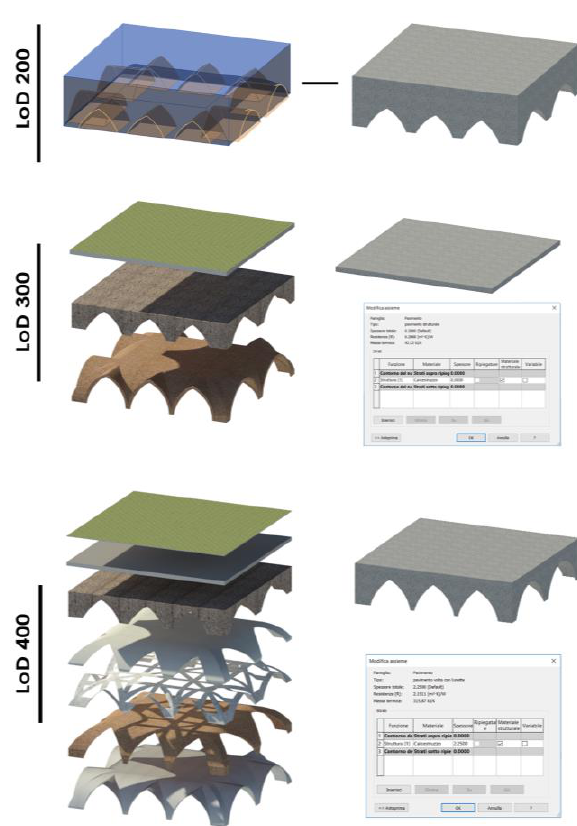
Figure 5. Modelling of a Cavetto vault with lunettes, with different Levels of Development: the LoD 200 vault (on the left the construction of a simplified model in-place of the vault, on the right the final result); the 300 LoD vault (the model in-place with a simplified stratigraphy of the vault and a simplified shape of a structural floor to be superimposed); the LoD 400 vault (the model in-place with a detailed stratigraphy of the vault and a detailed structural